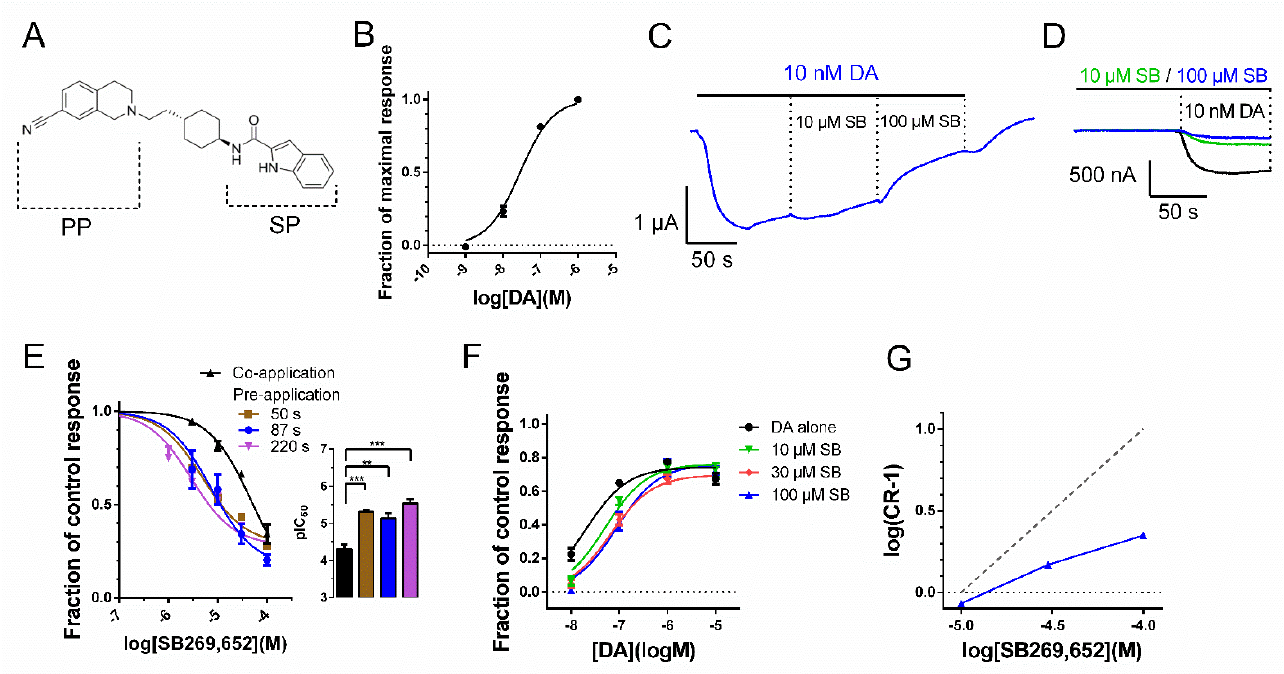
Figure 1. Pre-application increases SB269,652 potency at D 2 R. ( A ) Structure of SB269,652, indicating the THIQ primary pharmacophore (PP) and the indole-2-carboxamide secondary pharmacophore (SP). ( B ) Concentration-response relationship for DA at the WT D 2 R. Equation (1) was fit to the data as described in the Methods. ( C ) Representative trace showing the GIRK current response to application of 10 nM DA and subsequent addition of 10 and 100 µM SB269,652. ( D ) Representative traces from the same oocyte showing GIRK current responses to application of 10 nM DA following 87-s pre-application of 10 µM (green trace) or 100 µM (blue trace) SB269,652, or control buffer solution (black trace). ( E ) Concentration-response relationships for SB269,652, co-applied with 10 nM DA (black; pIC 50 = 4.31 ± 0.14 [49.0 µM], n = 3–6) or pre-applied alone during 50 s (brown curve, pIC 50 = 5.31 ± 0.06 [4.9 µM], n = 6), 87 s (blue curve, pIC 50 = 5.13 ± 0.16 [7.4 µM], n = 4–7), or during 220 s (purple curve, pIC 50 = 5.54 ± 0.11 [2.9 µM], n = 4). Data were normalized within cells to the response to 10 nM DA applied without SB269,652. Equation (2) was fit to the inhibition data as described in the Methods. Asterisks indicate statistical significance between the fitted pIC 50 parameters for the co- and pre-incubation conditions: **, p < 0.01; ***, p < 0.001, F-test. There were no significant differences when pIC 50 values estimated under the three different pre-application conditions were tested individually against each other. ( F ) Curve shift data for DA in the absence or presence of increasing concentrations of SB269,652. Curves show fits to Equation (1). DA pEC 50 s were estimated as 7.70 ± 0.08 under control conditions (black curve; n = 7–8) and as 7.30 ± 0.08 (green curve; n = 5–6), 7.17 ± 0.07 (red curve; n = 6), and 7.06 ± 0.11 (blue curve; n = 4) in the presence of 10, 30, or 100 µM SB269,652, respectively. Data are displayed as mean ± SEM. ( G ) Schild plot showing the logarithm of the curve shift ratio (CR)—1 as a function of SB269,652 concentration. The dotted diagonal line represents the unity slope expected of a competitive antagonist. Data represent means of EC 50 estimates from the curve fits in ( F ).